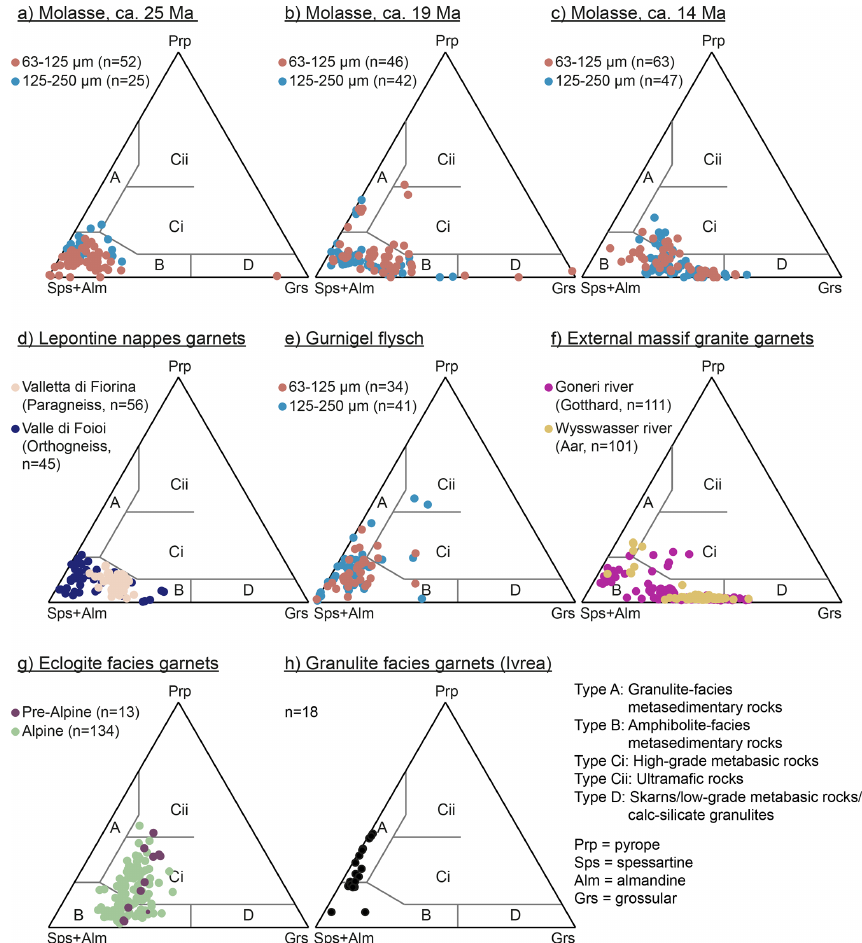
Figure 4. Garnet classification scheme of Mange and Morton (2007). (a–c) Detrital garnet compositions in the 25, 19, and 14Myr old Molasse deposits (this study). Source rock data from (d) Lepontine gneisses (this study), (e) the Gurnigel flysch (this study), (f) external massif granites (Stutenbecker et al., 2017), (g) eclogite facies rocks (Chinner and Dixon, 1973; Ernst and Dal Piaz, 1978; Oberhänsli, 1980; Sartori, 1990; Thélin et al., 1990; Reinecke, 1998; Cartwright and Barnicoat, 2002; Angiboust et al., 2009; Bucher and Grapes, 2009; Weber and Bucher, 2015), and (h) granulite facies rocks from the Ivrea zone in the southern Alps (Hunziker and Zingg,